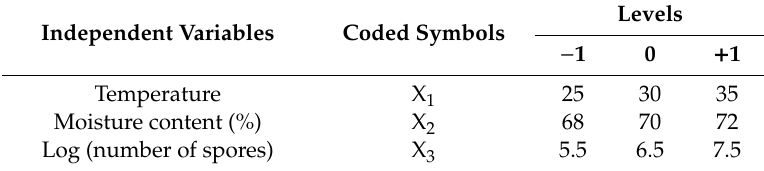
Table 3. Variables and level for Box–Behnken design for the optimisation of physical parameters. Independent Variables Coded Symbols